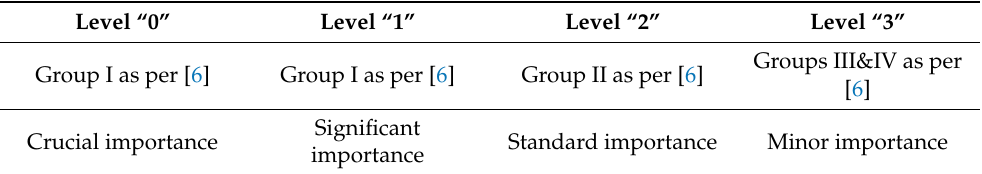
Table 8. The criticality levels used in the evaluation of the proposed health